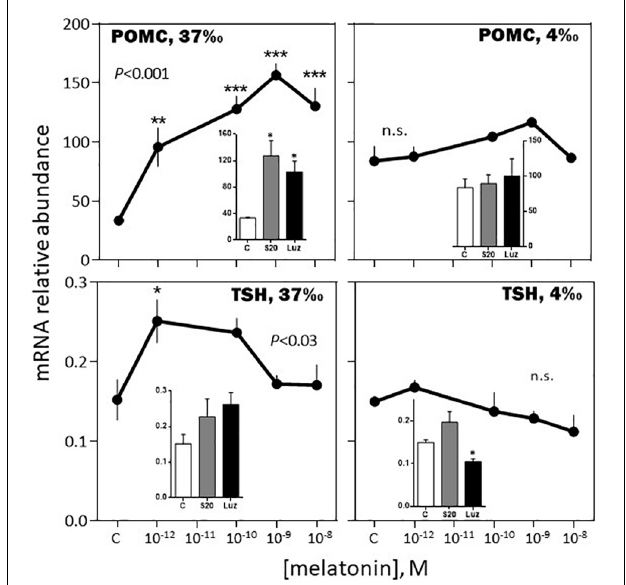
FIGURE 7 | Effects of melatonin and melatonin analogs on POMC and TSH mRNA relative abundance in vitro . Mean ± S.E.M. of n = 3 pools (containing 5 glands each). One-Way ANOVA ( P gives the level of significance; n.s.: non-significant). Means were compared to the corresponding control using the Holm-Sidak’s post hoc test: * P < 0.05, ** P < 0.005, *** P < 0.0005. The insets show the 12 h effects of two melatonin analogs S20304 (S20 at 10 – 8 M) and luzindole (Luz at 10 – 7 M). Mean ± S.E.M. of n = 3 pools (containing 5 glands each). Values are compared to the controls using the Student’s t -test at P < 0.01. See Figure 6 for more details.